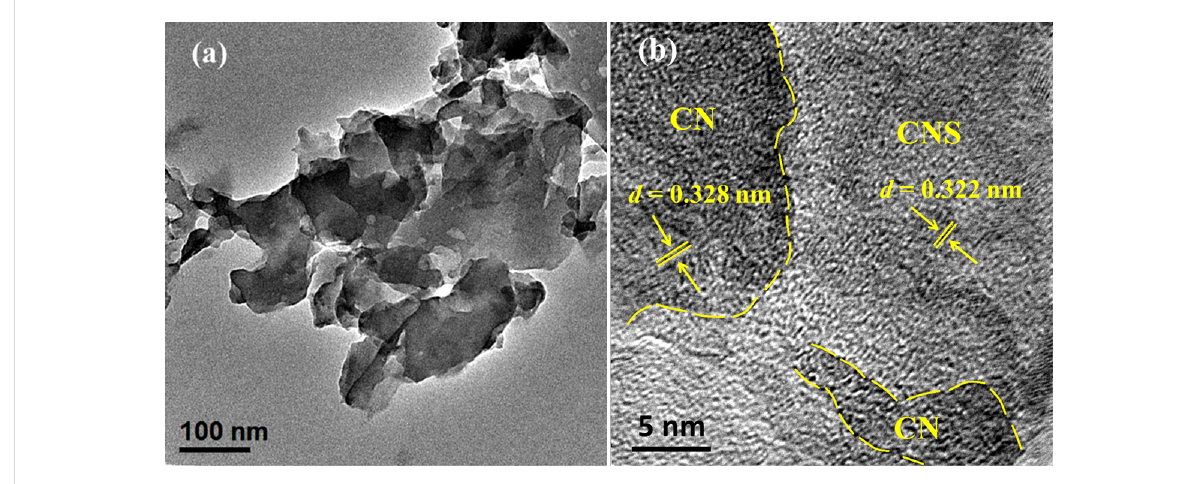
Figure 5: TEM (a) and HRTEM (b) images of a CN/CNS heterostructure.